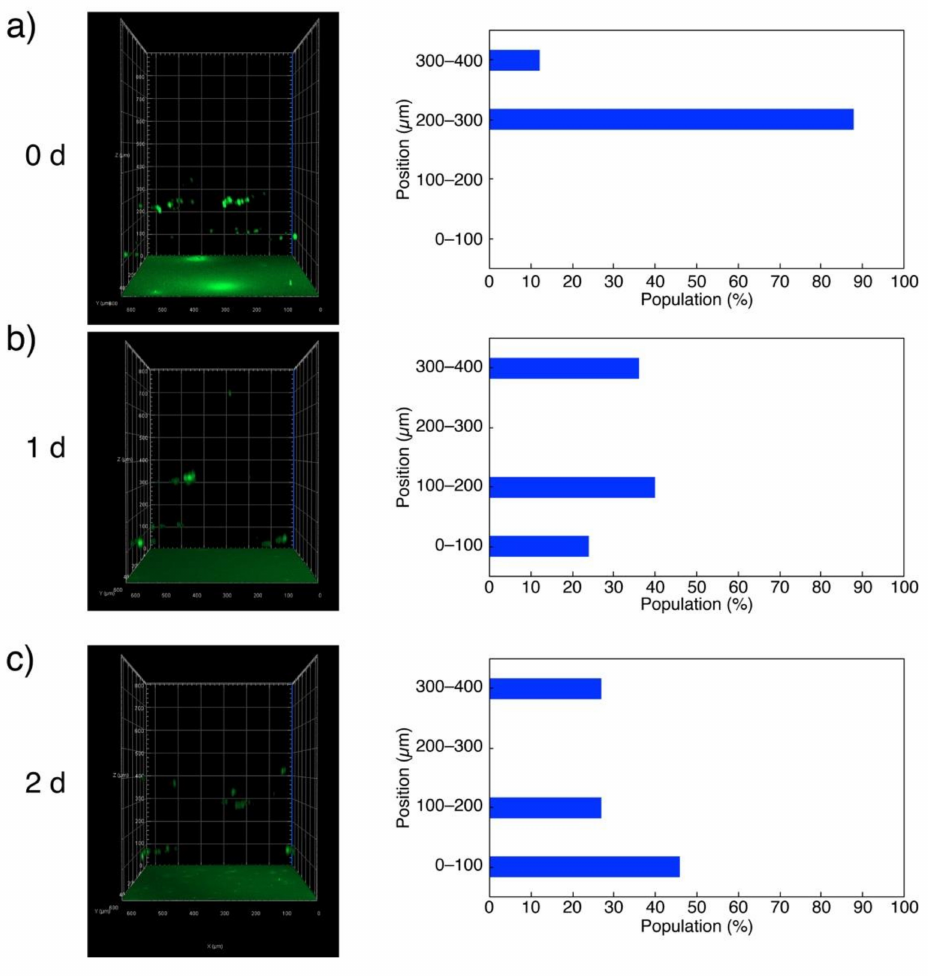
Figure 4. Confocal laser scanning fluorescence microscope (CLSM) 3D images of L929 fibroblast cells labeled with CellTracker ™ Green dye and deposited on 15 wt % L4.6k-dG4 hydrogels after 0 day ( a ), 1 day ( b ), and 2 days ( c